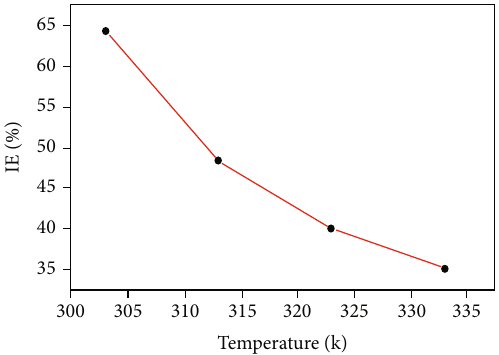
Figure 2: Inhibition e ffi ciency of 250ppm of 3-NA in 1N HCl for MS in temperature ranging from 303 to 323